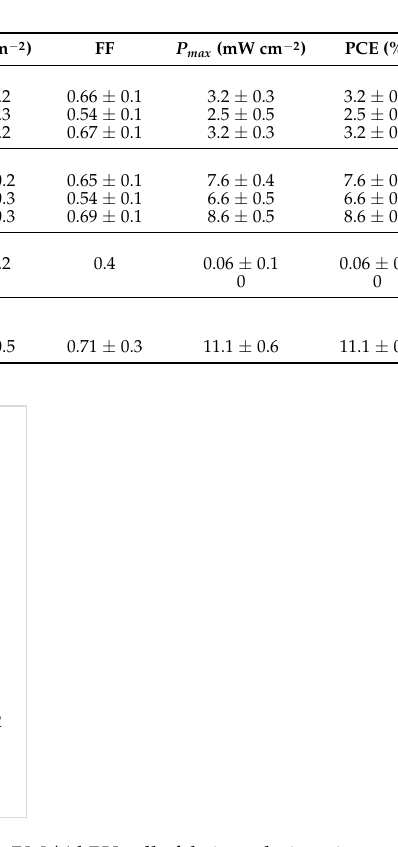
Figure 4. J – V plots for the ITO/PEDOT:PSS/P3HT/PC 61 BM/Al PV cells fabricated via spin coating (SC) or inkjet printing (IP) of all layers or spin coating of PEDOT:PSS and inkjet printing of the P3HT/PC 61 BM solution (SC-IP).